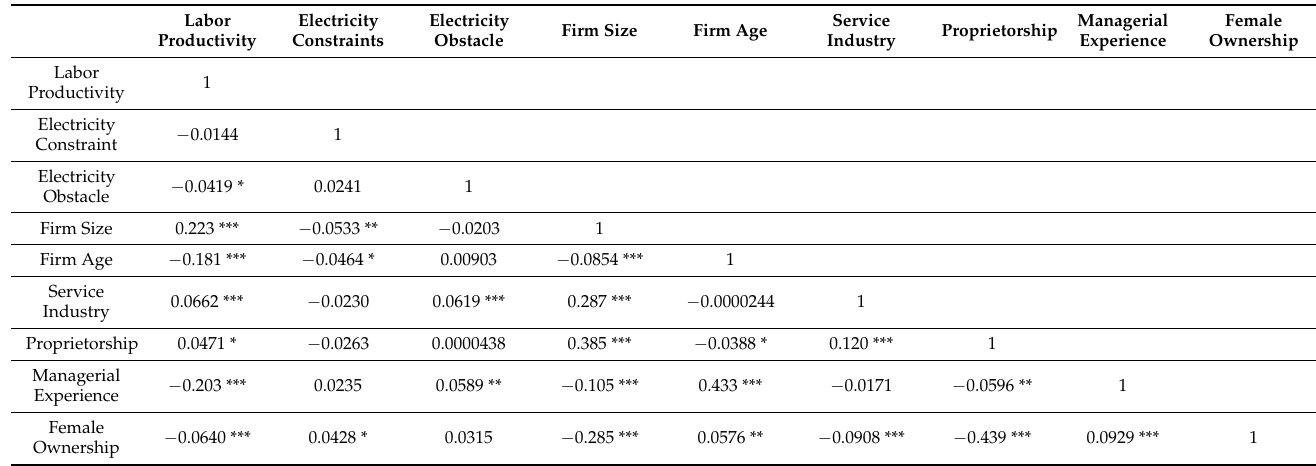
Table 3. Correlation matrix.